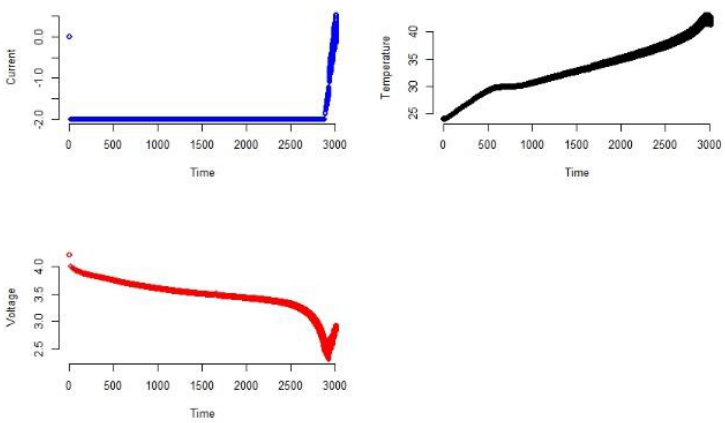
Figure 3. Graphical demonstration of the fPCA for monitoring data. The mean functions and eigenfunctions of ( a ) voltage, ( b ) current, and ( c ) temperature are displayed.